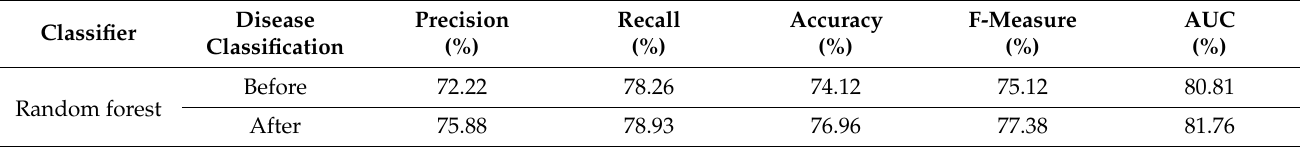
Table 6. Comparison of the performance of the 5-year incubation period model before and after the disease classification. Classifier Random